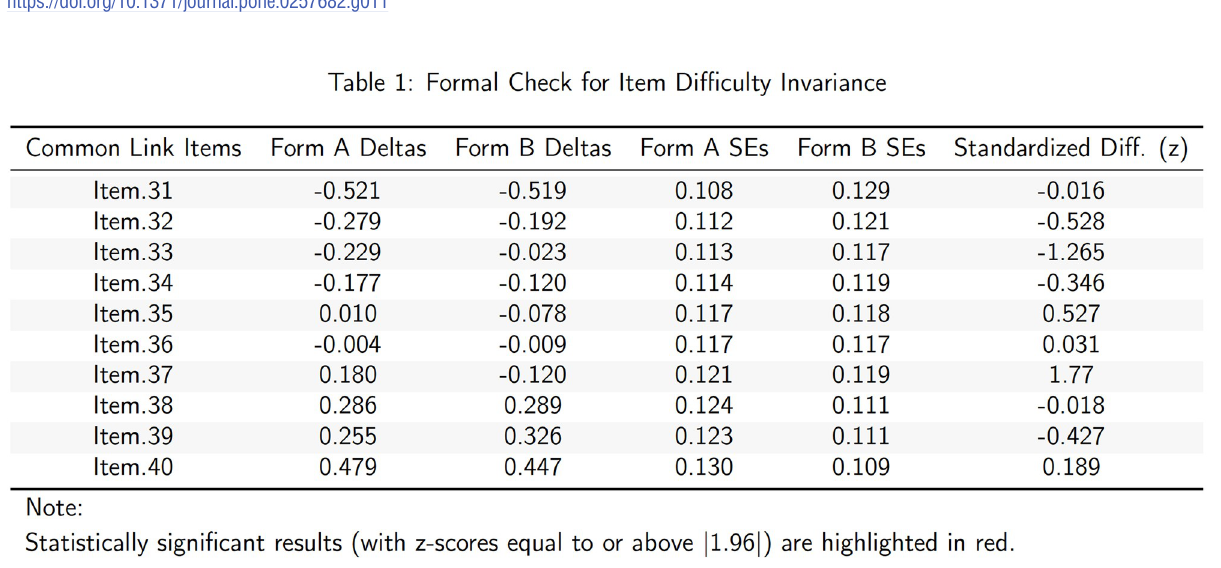
Fig 12. Formal test of link item invariance table.